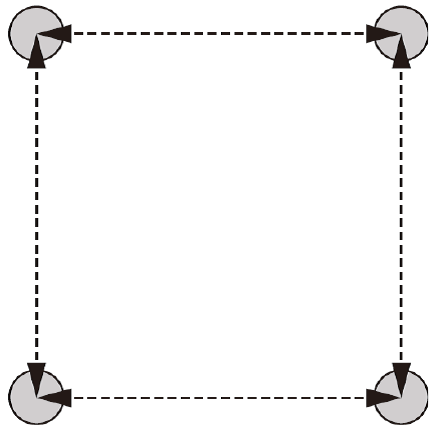
Fig. 11. All ant agents settled in the